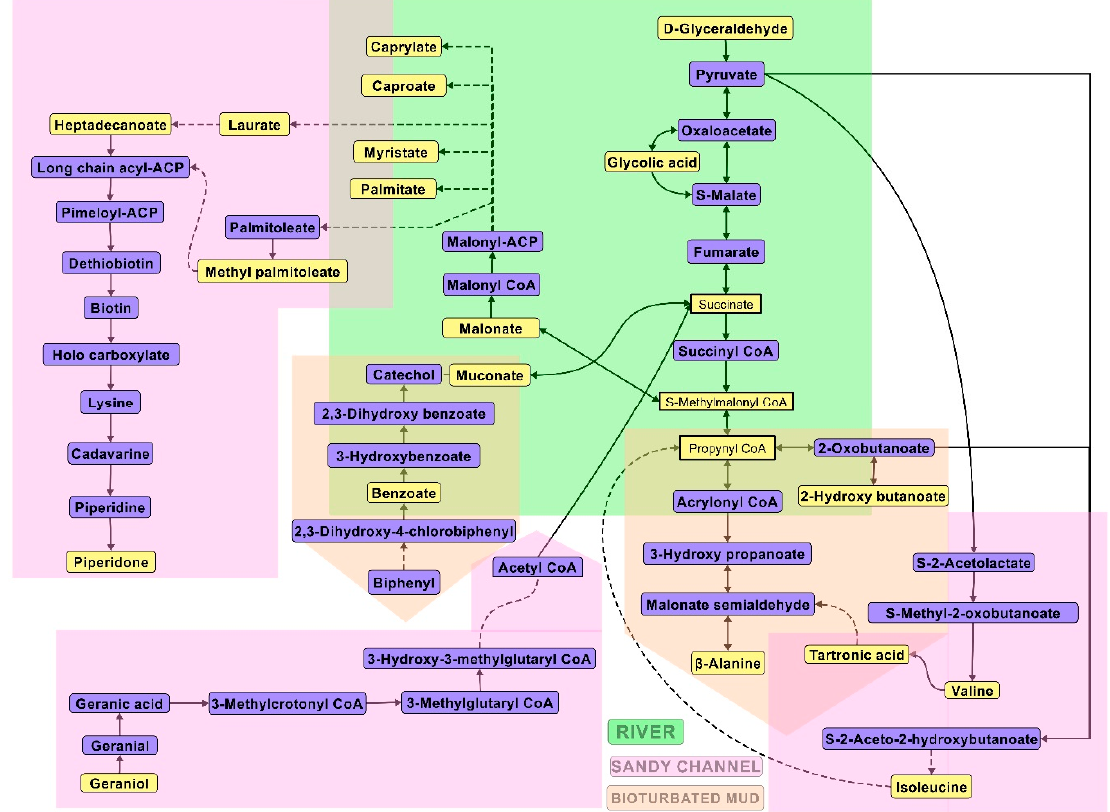
Figure 3. Important connecting metabolites expressed in various sediments. It was noted that the metabolic flux shifted downstream from river to sandy channels due to the differential microbial communities. Note: the metabolites highlighted with yellow boxes denote the primary interface metabolites with high fold change (FC) values, as detected by GC-MS.